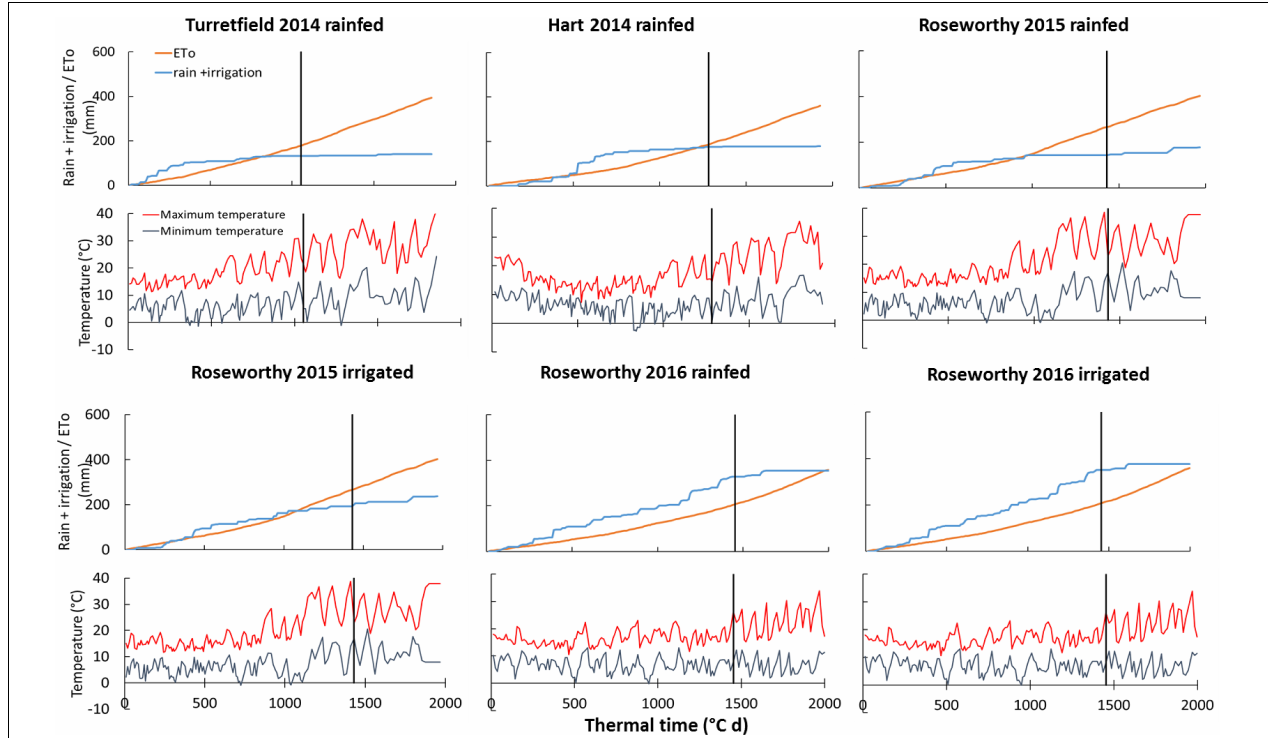
FIGURE 1 | Cumulative reference evapotranspiration (ETo), cumulative rain and irrigation, and temperature against thermal time from sowing in six environments in South Australia. Vertical lines indicate anthesis sampling. ETo is calculated with the FAO-56 method (Allen et al., 1998).